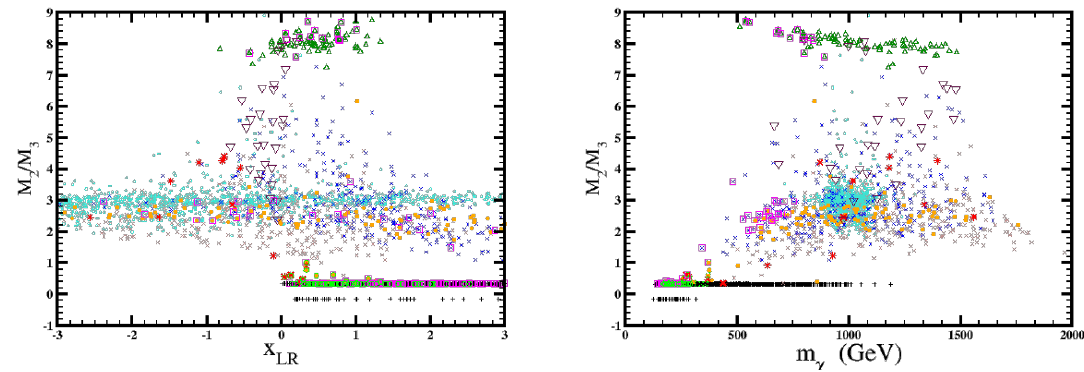
Figure 2 . Scatter plots showing the di(cid:11)erent Planck areas as functions of the ratios of the GUT values for the soft terms, using the same notation as in (cid:12)gure